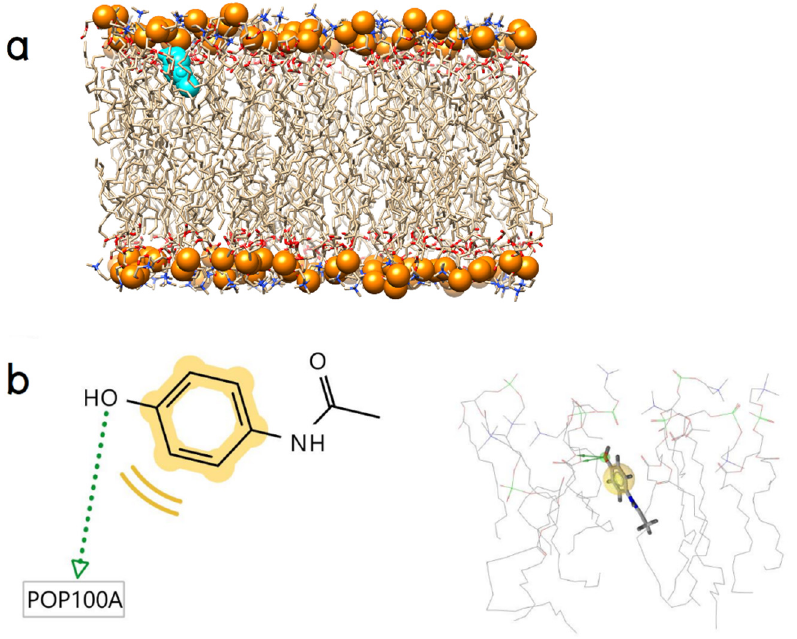
Figure 5. ( a ) An initial position of paracetamol (cyan surface) and ( b ) Its binding modes (the yellow sphere represents a hydrophobic feature, and the green arrows represent hydrogen bond do- nors).